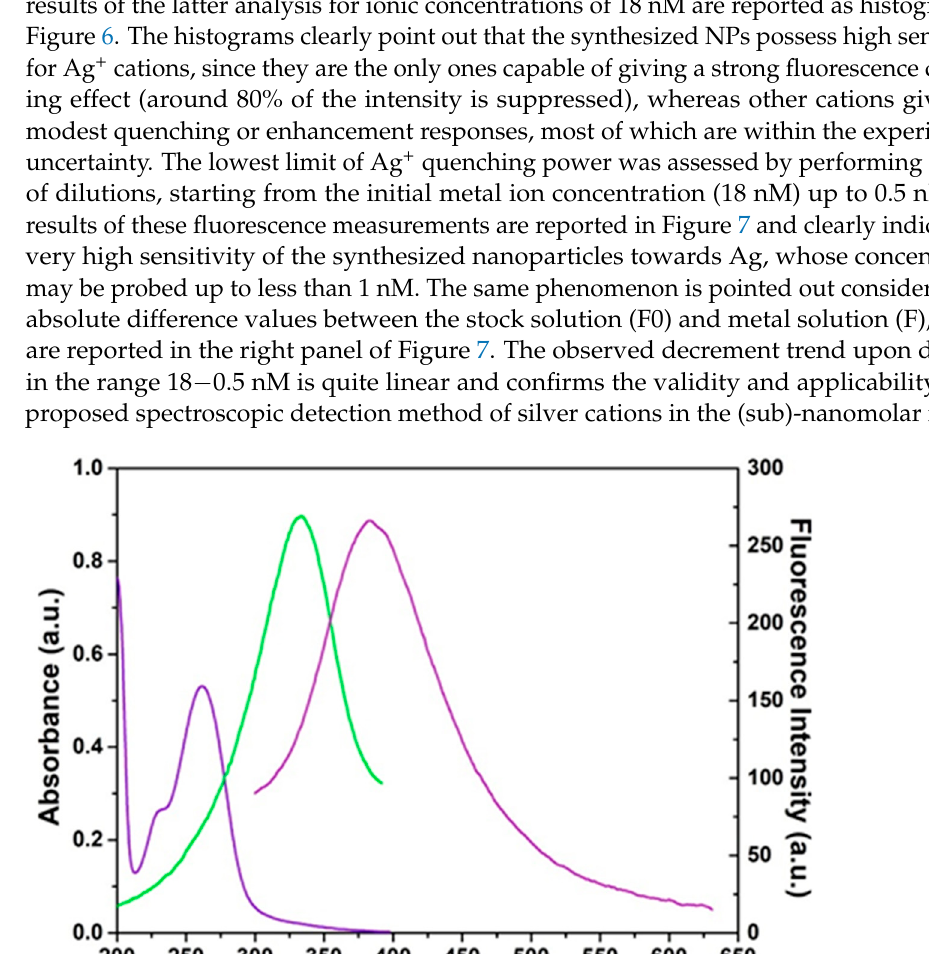
Figure 6. Normalized fluorescence intensity ratio of the various metal N-CQDs water solutions (metal concentration = 18 nM).